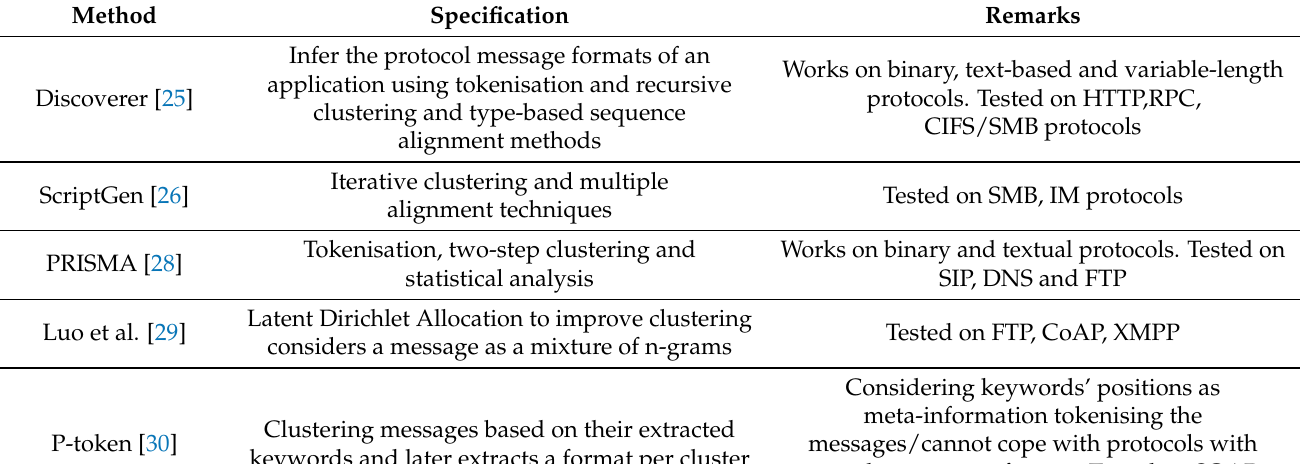
Table 2. Different approaches of full message format